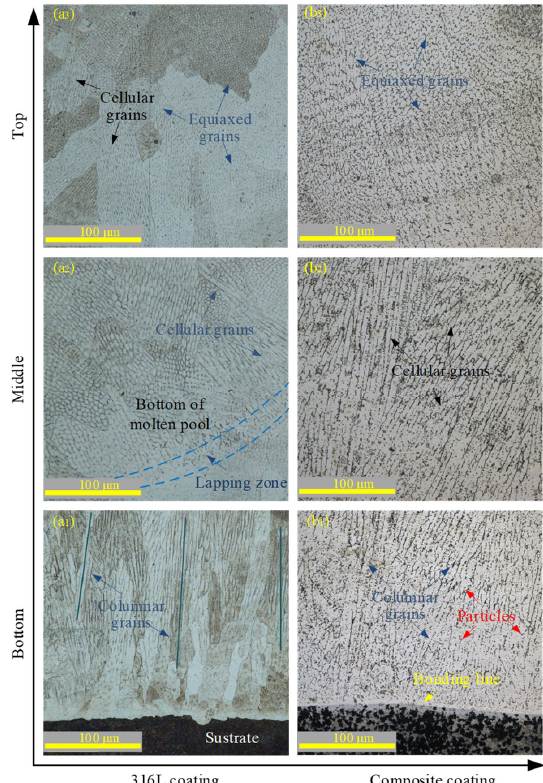
Figure 3. Optical microstructures: ( a1 – a3 ) 316L coating and ( b1 – b3 ) composite coating.